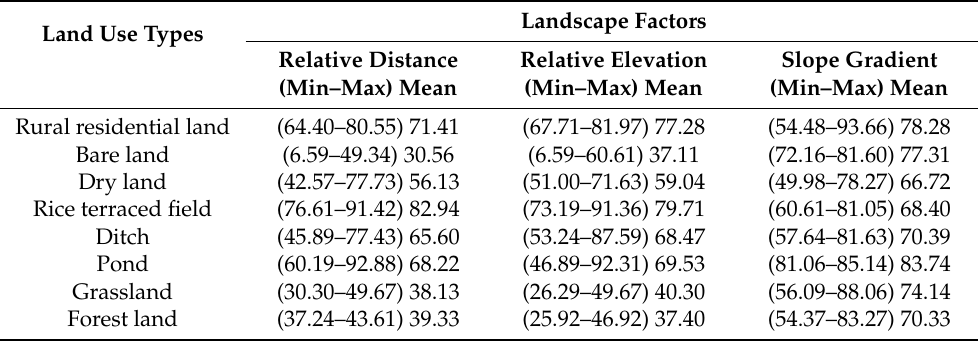
Table 5. Lorenz curve of the accumulated area percentages of source and sink landscapes related to landscape factors in the five watersheds (unit: